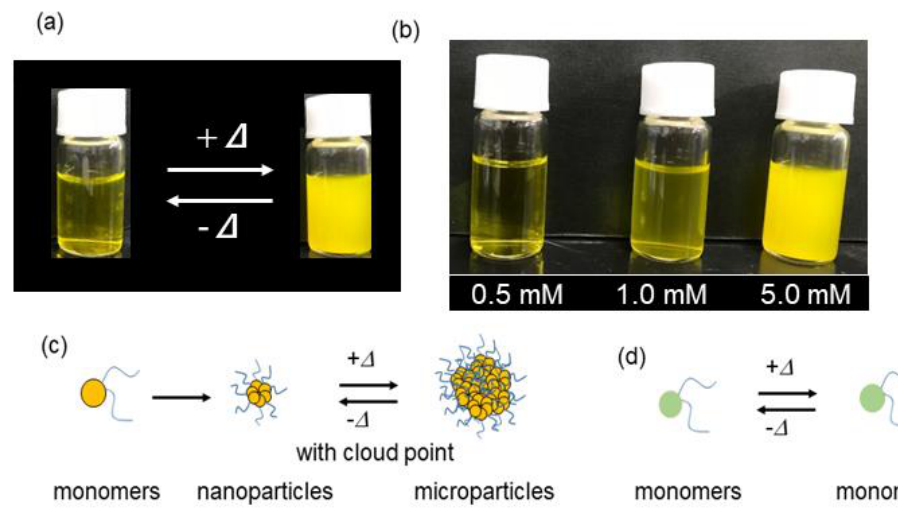
Figure 3. ( a ) Representative image of the vials containing 5.0 mM TFMAQ-diEg4 solutions, at 20 ◦ C ( left ) and 30 ◦ C ( right ). ( b ) Representative image of TFMAQ-diEg4 solutions of various concentrations, at 37 ◦ C. The proposed self-assembly mechanisms are given for the concentrated solutions ( c ) and diluted solution with or without heat ( d